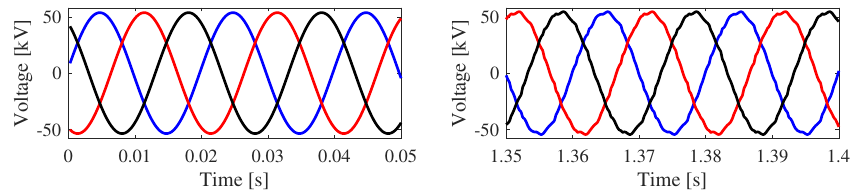
Figure 20. Three-phase voltages before ( left ) and after ( right ) the power ramp-up of